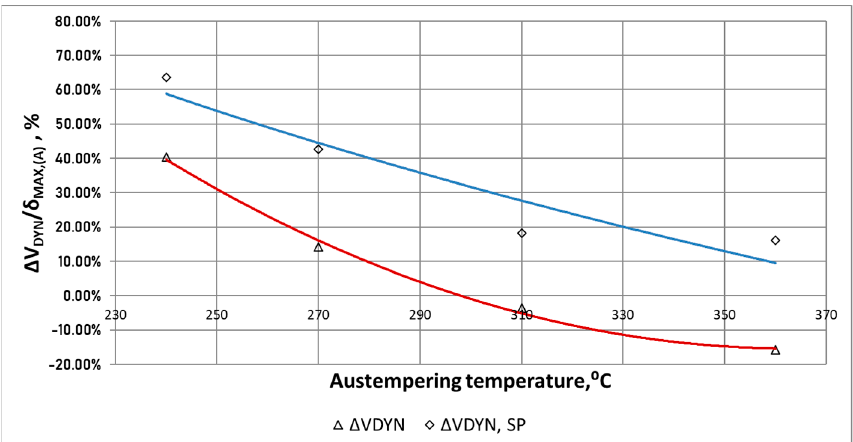
Figure 18. Waveforms of the relative increase in the wear Δ W DYN / δ MAX,(A) as a function of the tem- perature of isothermal quenching of the tested ADI. temperature of isothermal quenching of the tested